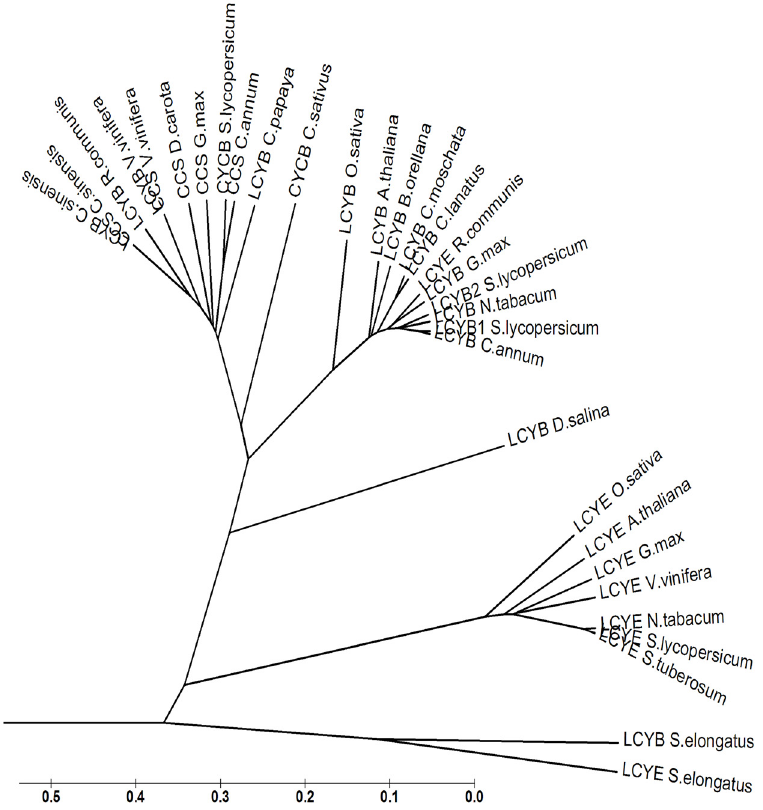
Fig 7. Phylogenic tree showing the similarities between amino acid sequences of CYC-B and its homologues. The analysis involved 32 amino acid sequences. Evolutionary analyses were conducted in